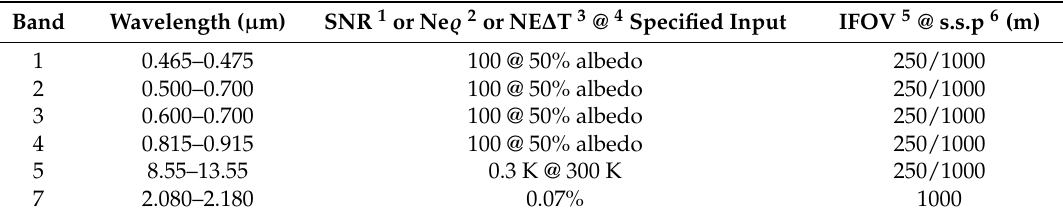
Table 1. Properties of the Medium Resolution Spectral Imager (MERSI) bands used. Band Wavelength (μm)